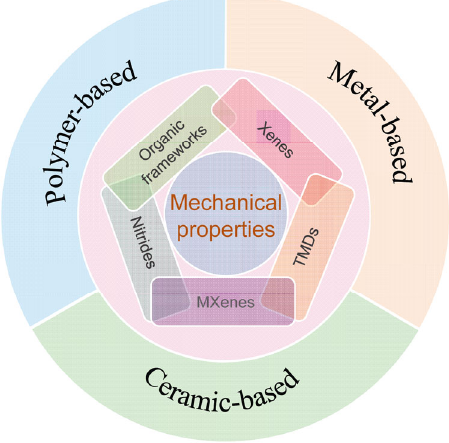
Fig. 2 Types of 2D nanomaterials and composites considered in this review.